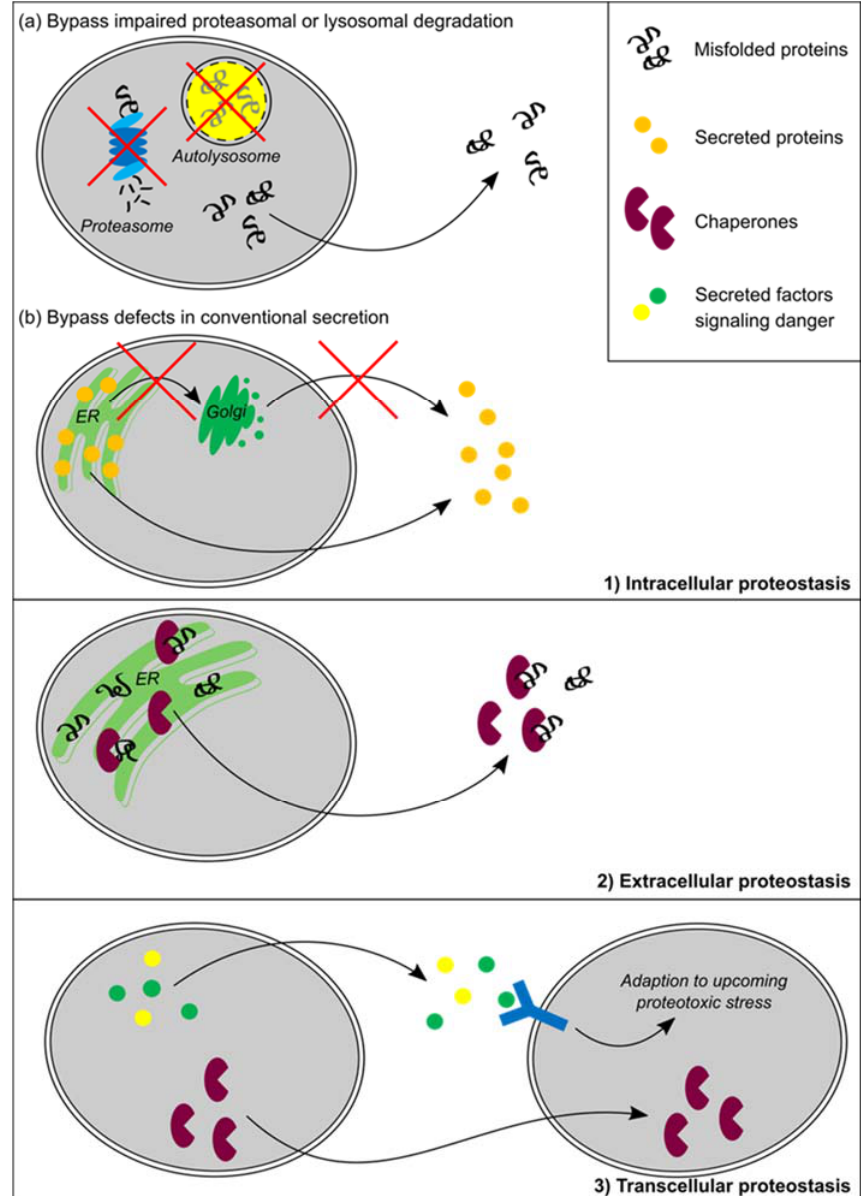
Figure 3. Putative proteostatic functions of cell non ‐ autonomous UPR signaling. Schematic depiction of three hypotheses showing possible functions of cell non ‐ autonomous UPR signaling. ( 1 ) Upon protein stress, accumulating or misfolded proteins from ER or cytosol are secreted to maintain intracellular proteostasis. For example, impairment of proteasomal or autolysosomal degradation ( a ) or defects in the conventional secretory pathway ( b ) have been observed to cause protein stress and induce protein secretion. ( 2 ) ER chaperones are secreted alone or together with misfolded proteins, to maintain or restore proteostasis in the extracellular space. ( 3 ) Cells that experience proteotoxic stress can secrete “danger signals” or DAMPs to alert recipient cells for upcoming proteotoxic insults. In addition, chaperones can be secreted to compensate chaperone levels between cells. Both forms of transcellular communication can contribute to proteostasis at the tissue or organismal level. For details, see main text.